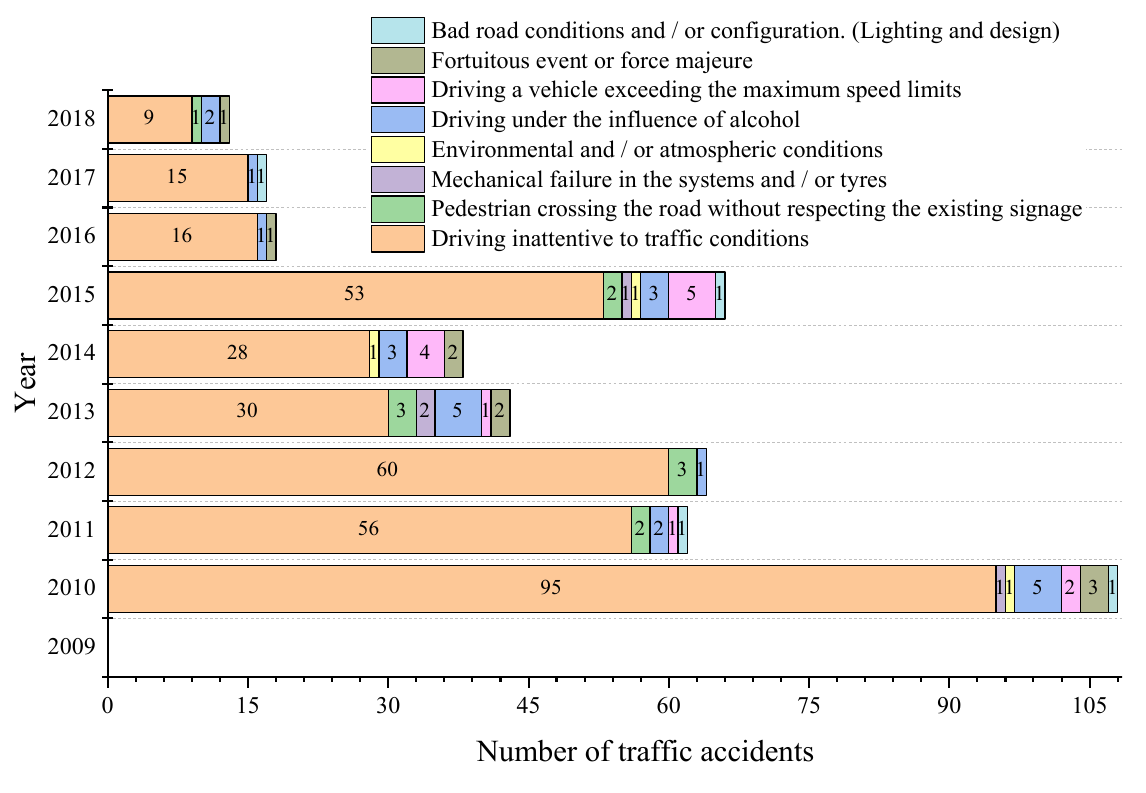
Figure 18. Traffic accident causes per year for subcategory N1.